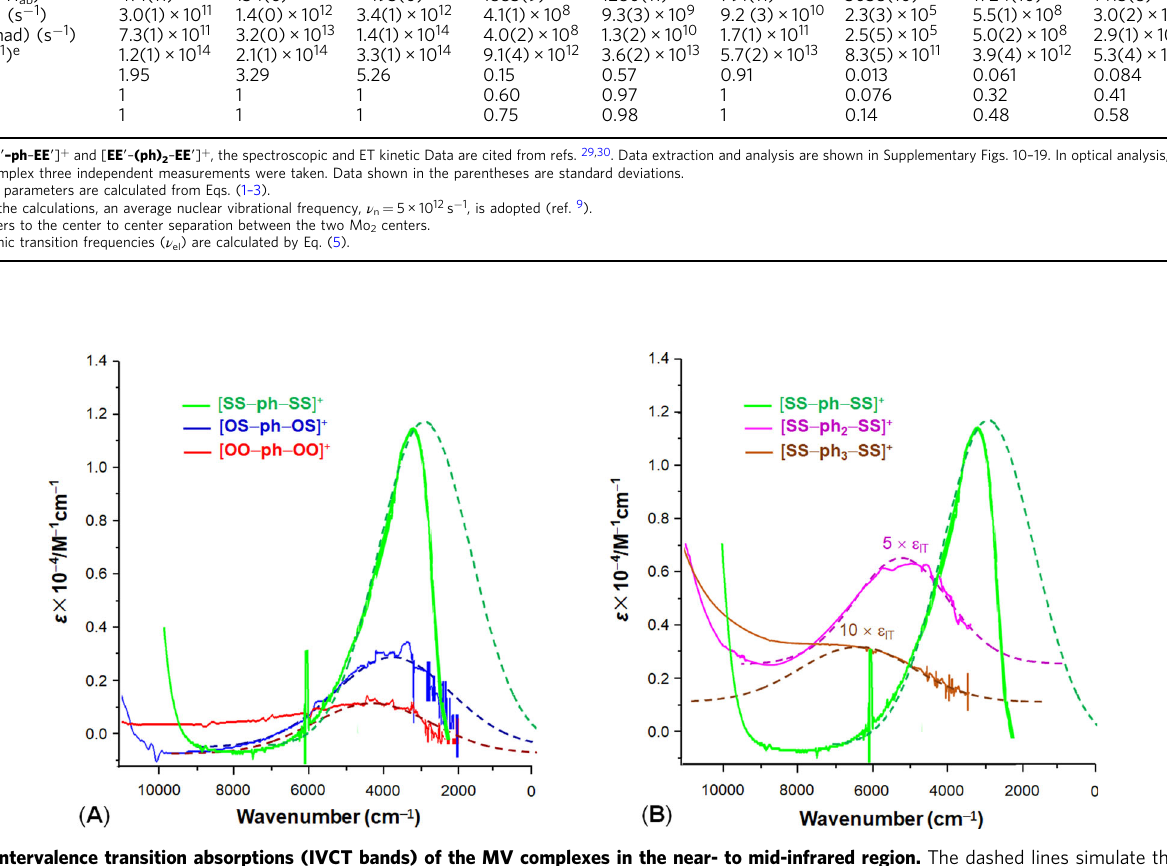
Fig. 2 Intervalence transition absorptions (IVCT bands) of the MV complexes in the near- to mid-infrared region. The dashed lines simulate the Gaussian-shaped band pro fi les to show the spectral asymmetry or spectral “ cut-off ” , which is attributed to strong donor – acceptor electronic coupling.